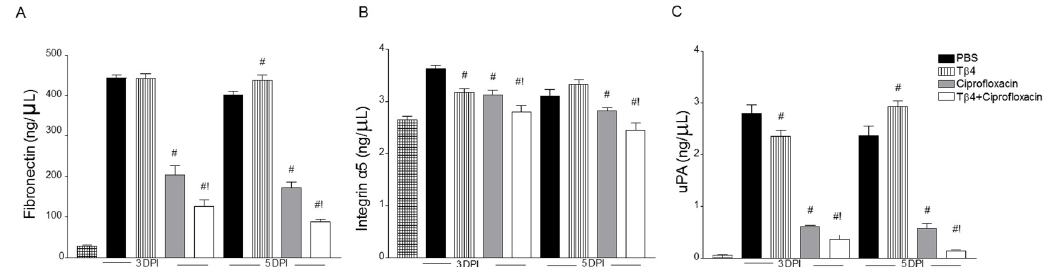
Figure 7. Protein levels of fibronectin ( A ), ITGα5 ( B ), and uPA ( C ) in corneas of PBS-, Tβ4-, ciprofloxacin-, and Tβ4 + ciprofloxacin-treated B6 mice at 3 and 5 days p.i. and uninfected (normal) controls. Results are reported as mean (ng/mL) ± SEM. N = 5 corneas/group/time point. # P < 0.05 versus PBS; ! P < 0.05 versus ciprofloxacin.